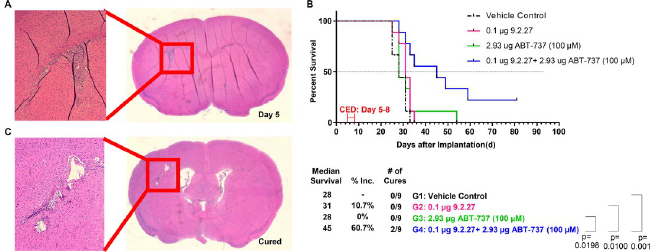
B. Survival curve post-therapy and statistical analysis. C. H&E staining of a representative brain section harvested from one of the cured mice post 9.2.27-PE38KDEL and ABT-737 combination therapy.